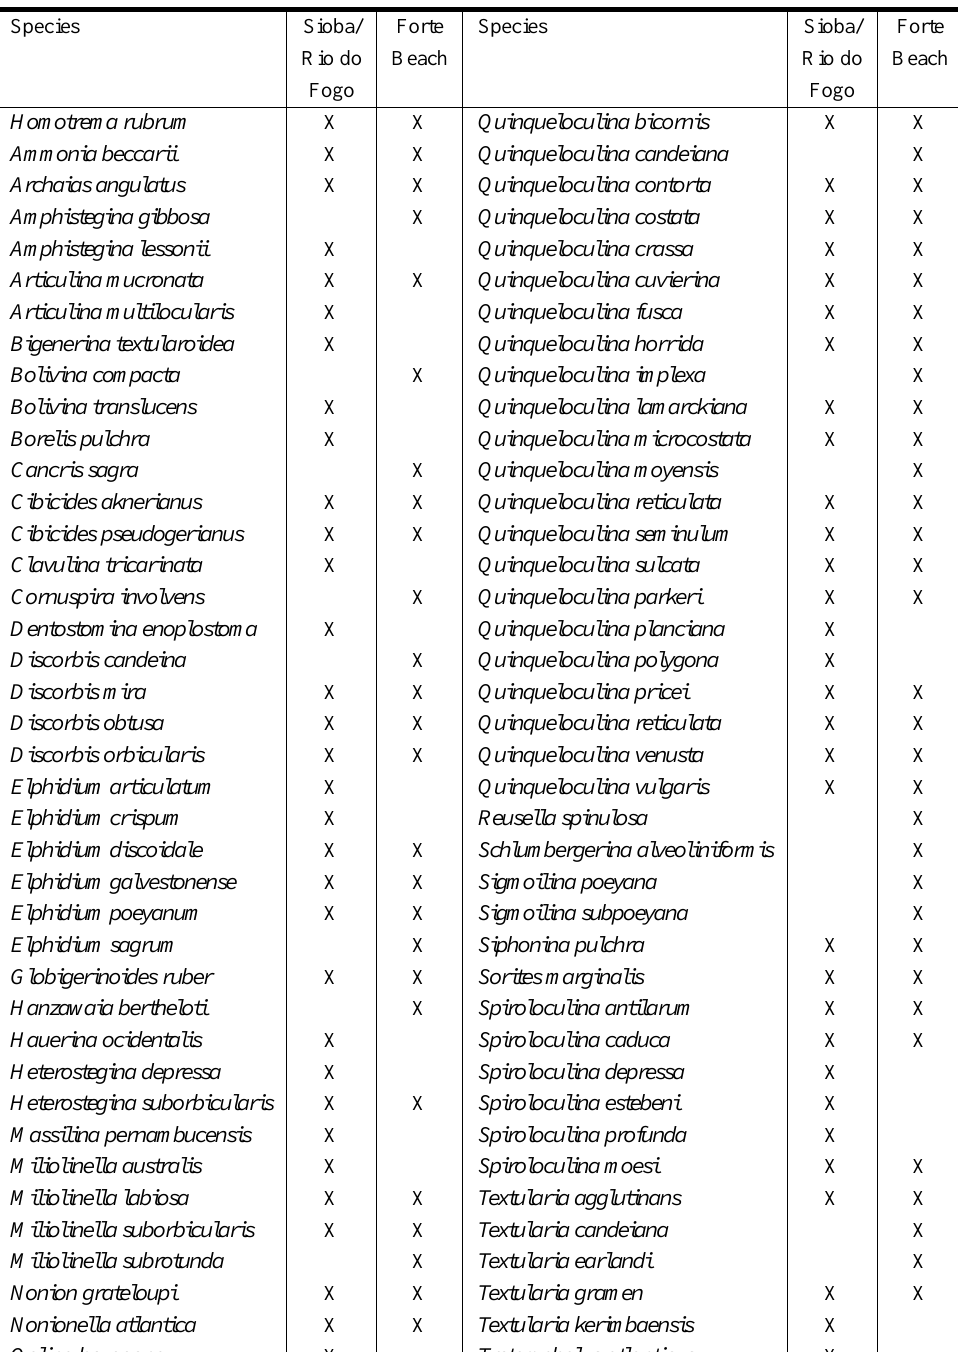
TABLE I Foraminifera species identified in the studied